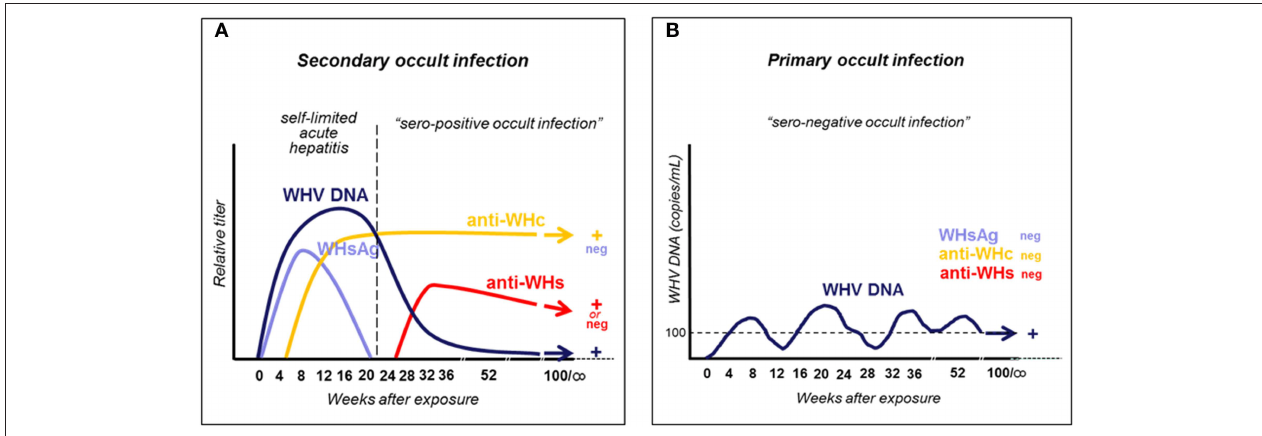
FIGURE 1 | Schematic presentation of serum immunovirological and molecular profiles of occult infections caused by WHV. (A) Secondary occult infection (SOI) continuing after resolution of self-limited acute hepatitis caused by a liver pathogenic dose greater or equal to 1 × 10 3 WHV characterized by persistent asymptomatic infection negative for serum WHsAg but reactive for anti-WHc antibodies, positive or negative for anti-WHs antibodies, and positive for WHV DNA at levels below 100–200 virus copies/mL. (B) Primary occult infection (POI) developing after exposure to a liver non-pathogenic dose of < 1 × 10 3 WHV virions that persists as a seronegative infection but remains serum WHV DNA reactive at levels usually below 100–200 virus